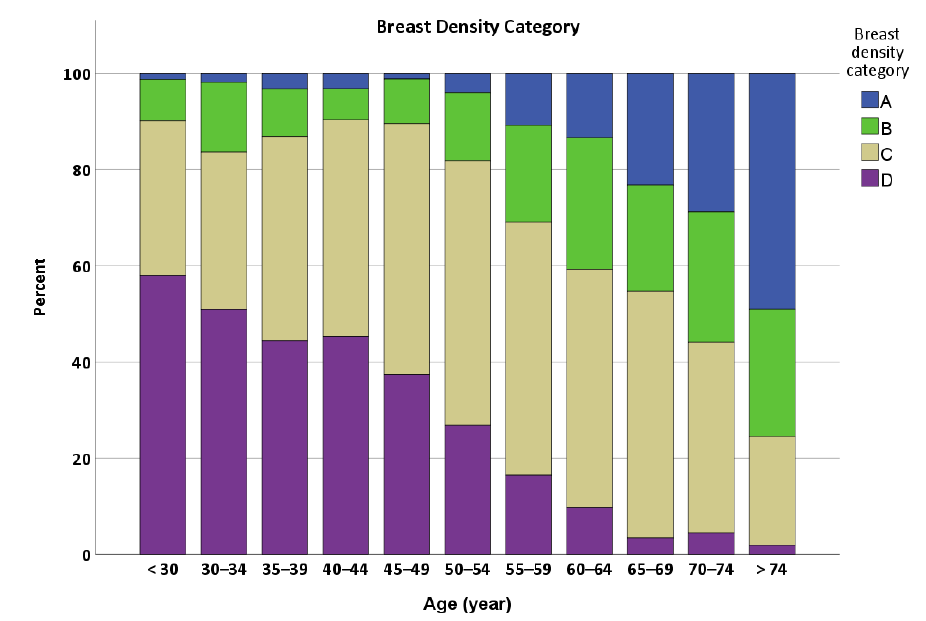
Figure 1. Histogram showing the proportion of breast density categories by age group, using the 5th edition of the Breast Imaging Reporting and Data System (BI-RADS). Note: Category A, almost entirely fatty; category B, scattered areas of fibroglandular density; category C: heterogeneously dense; and category D: extremely dense. Int. J. Environ. Res. Public Health 2020 , 17 , x FOR PEER REVIEW